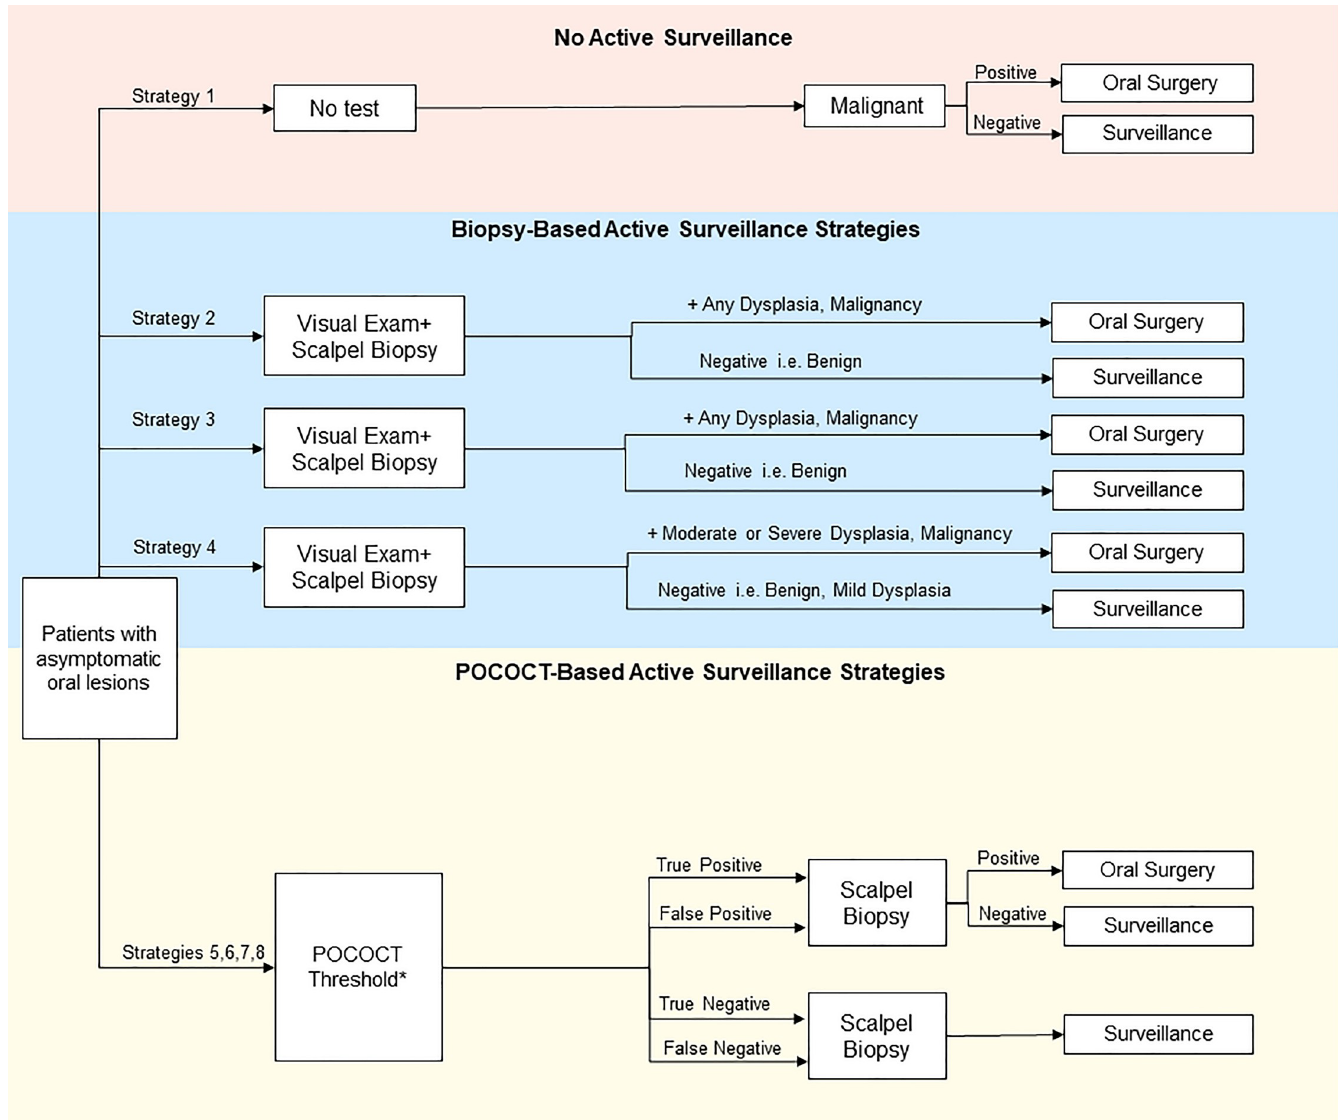
Fig 2. Simplified schematic of decision-analytic model summarizes active management strategies and testing consequences in the management of OPMDs. In addition to these management strategies, an additional “deferred evaluation and testing” pathway was constructed for comparison. � POCOCT generates a numerical score using the four different diagnostic splits among the 6 POCOCT risk categories spanning benign, dysplastic, and carcinomatous results. These diagnostic splits (e.g. mild|moderate dysplasia) were tested to determine the ideal thresholds for performing confirmatory biopsy and treating dysplasia or malignancy. For instance, use of the mild|moderate split entailed biopsy if positive, then surgical resection of moderate or severe dysplasia and carcinoma, while benign lesions and mild dysplasia histologic findings were placed on POCOCT-based surveillance. Similarly, splits of benign|mild, moderate|severe, and low-risk|high-risk moderate dysplasia were applied to separate test-treat